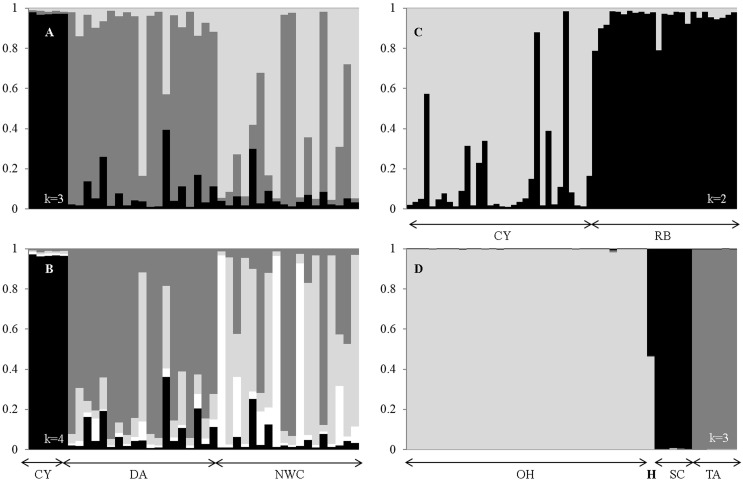
Structure plots for humpback dolphins where k = 3 (A) and k = 4 (B), for snubfin dolphins (C), and the three regularly encountered dolphin species at Cygnet Bay (D). k = number of clusters.Each bar on the x-axis corresponds to an individual. The y-axis indicates the proportion of population/species membership. OH = snubfin dolphins, SC = humpback dolphins, CY = Cygnet Bay, DA = Dampier Archipelago, NWC = North West Cape, RB = Roebuck Bay, H = suspected hybrid, TA = bottlenose dolphin.